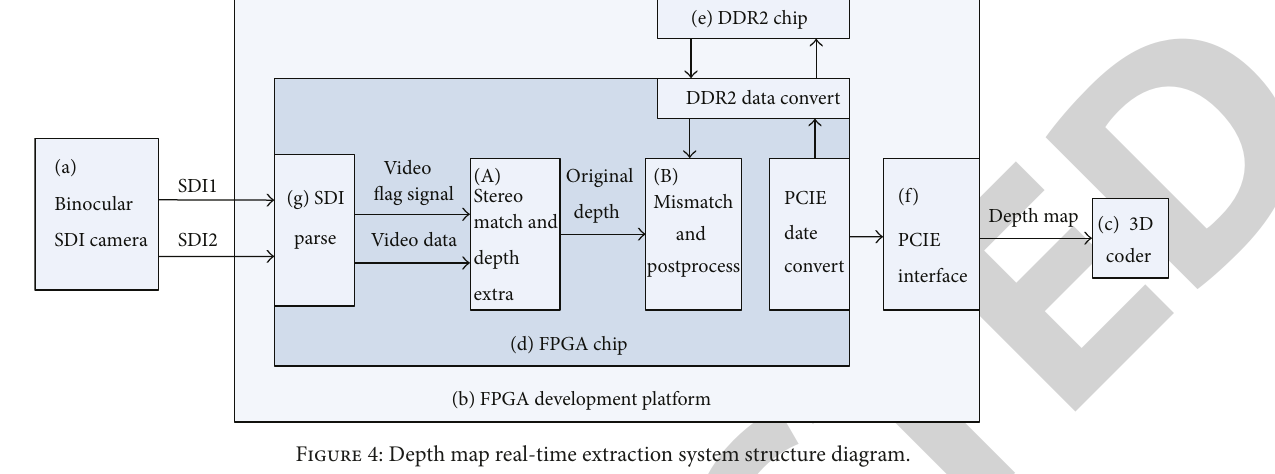
Figure 4: Depth map real-time extraction system structure